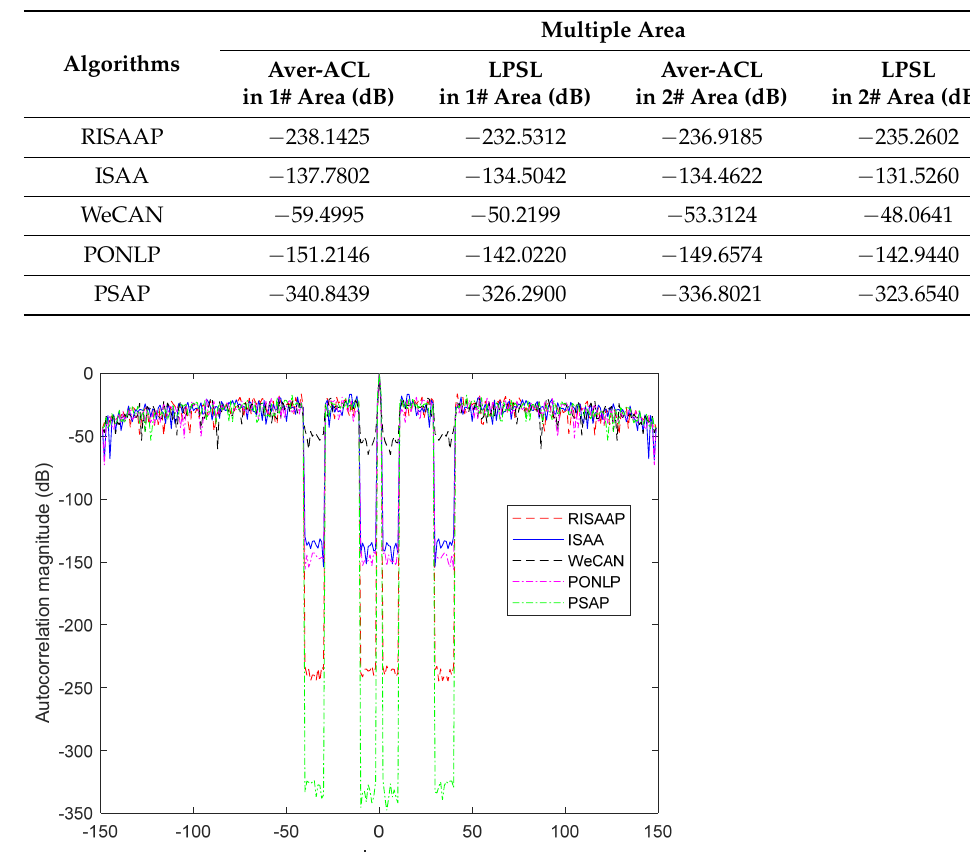
Table 3. Performance comparison for suppressing multiple area sidelobes with same weights.